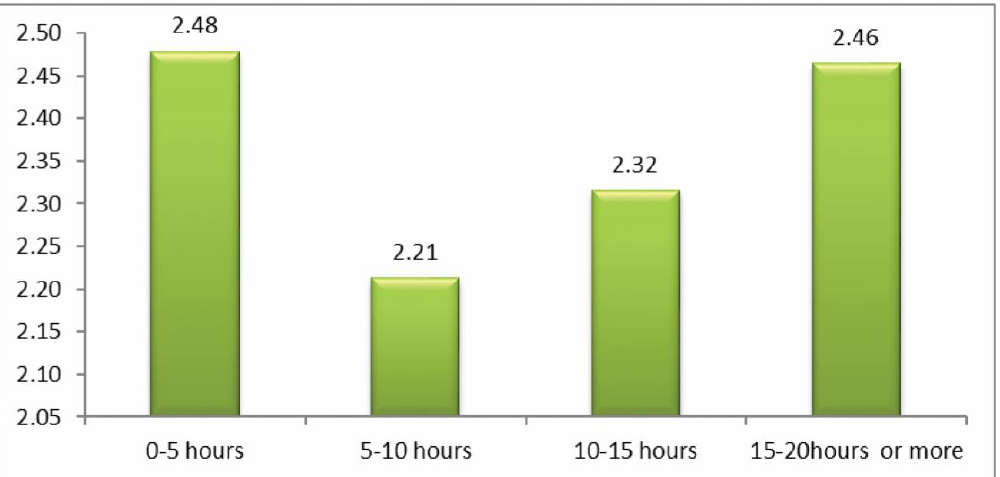
Figure 6. The risk of being a cybervictim (4-point scale), by time spent per week on the internet for the adolescents who were cyberbullied ( n = 163).